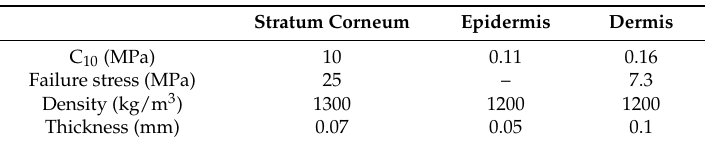
Table 1. Mechanical properties of human skin.